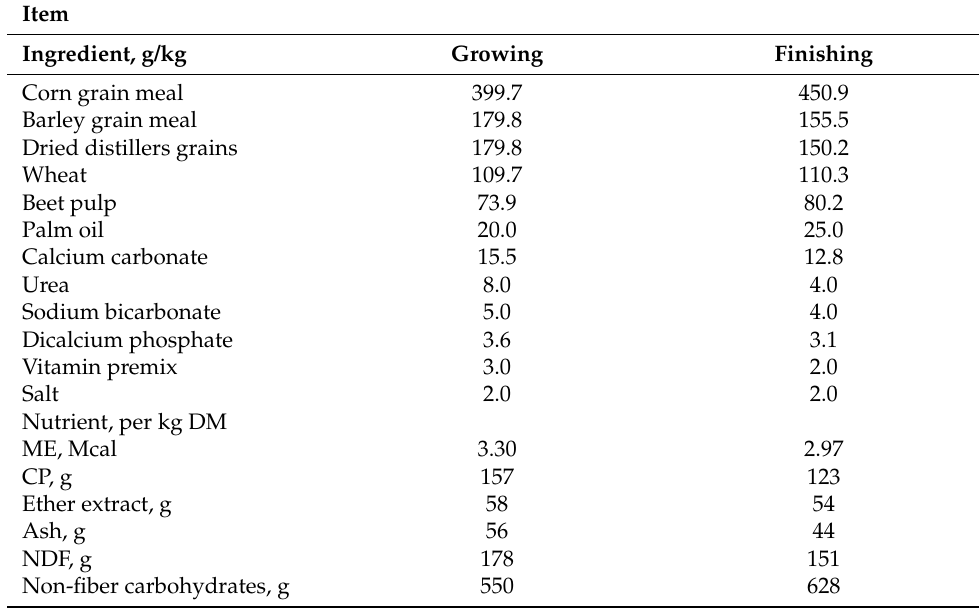
Table 1. Ingredient and nutrient composition of the dietary